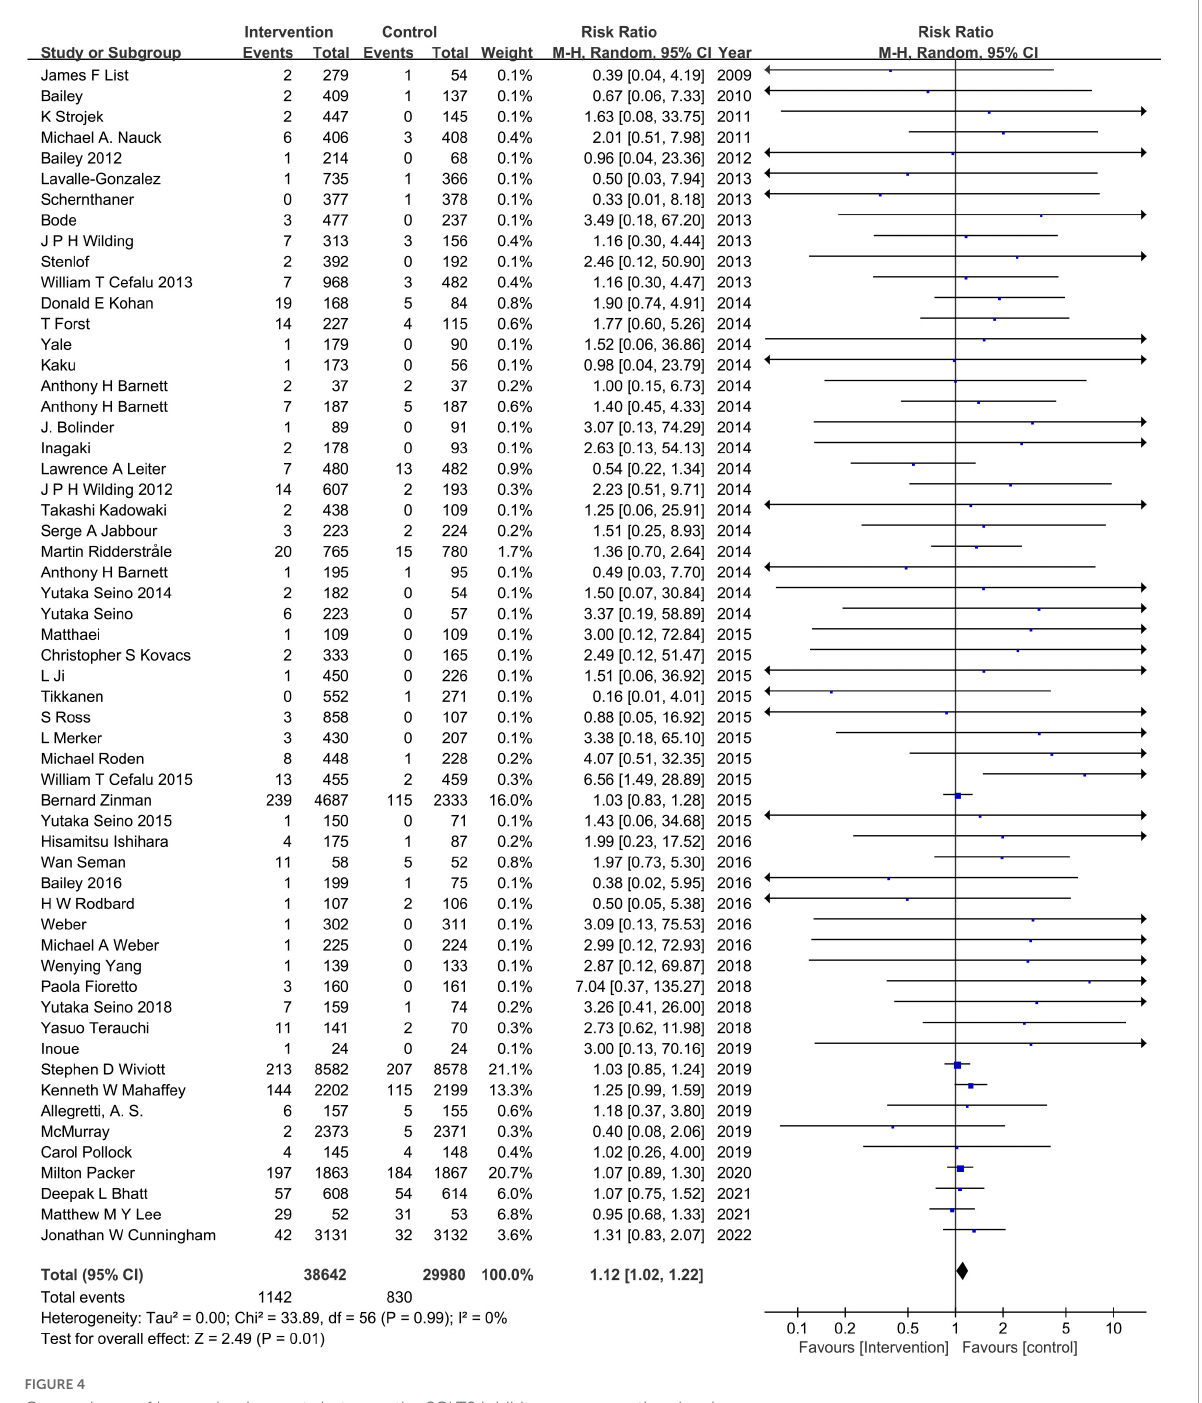
SGLT2 inhibitors, the majority of them focuses on analyzing the risk of hypoglycemia, and genital and urinary tract infections (67). Some of them threw light on the osmotic diuresis-related adverse event, with the result of there being no evidence of